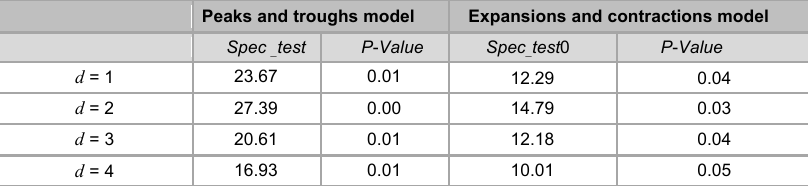
Non-linearity test and the optimal time-delay parameter Peaks and troughs model Expansions and contractions